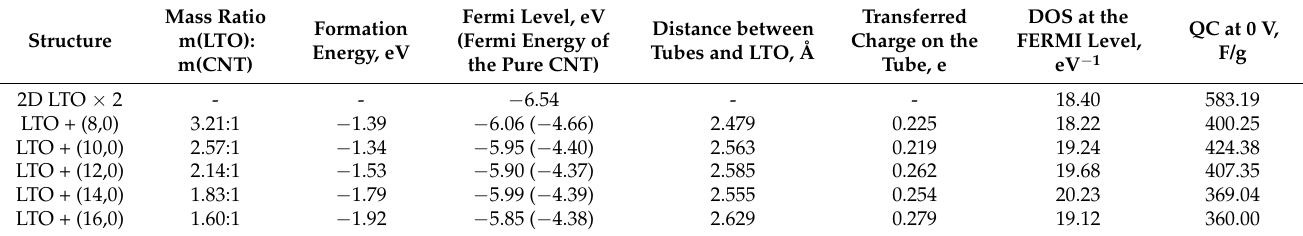
Table 2. Electronic and energetic properties of the CNT/LTO composite with different mass ratios.